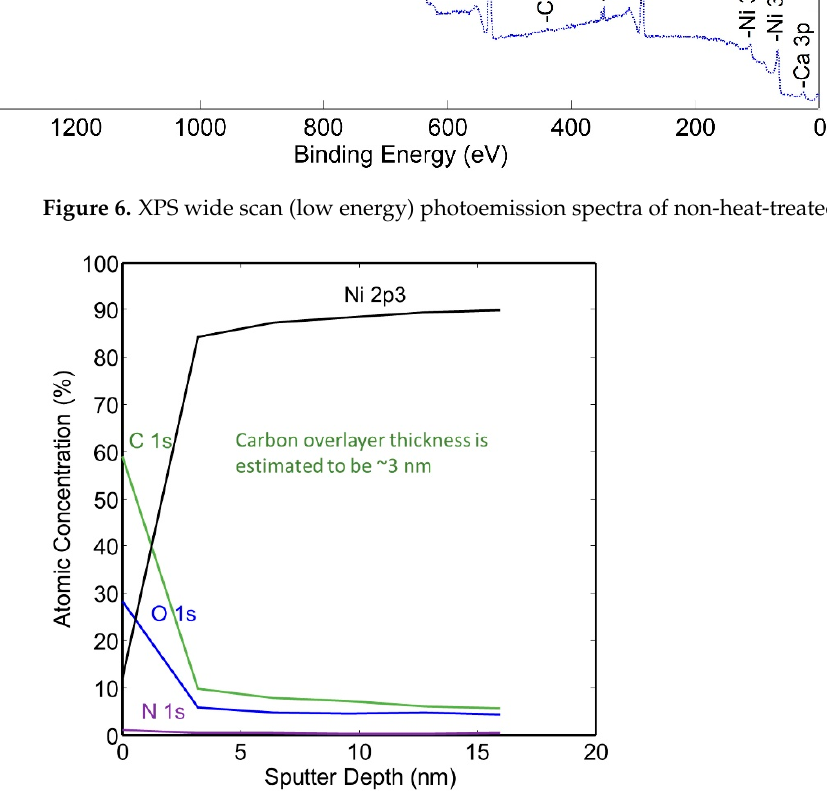
Figure 6. XPS wide scan (low energy) photoemission spectra of non-heat-treated NPG a-sample .